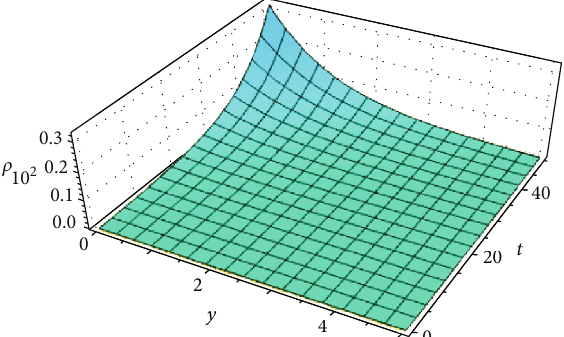
Figure 13: The gyroradius  versus space y and time t